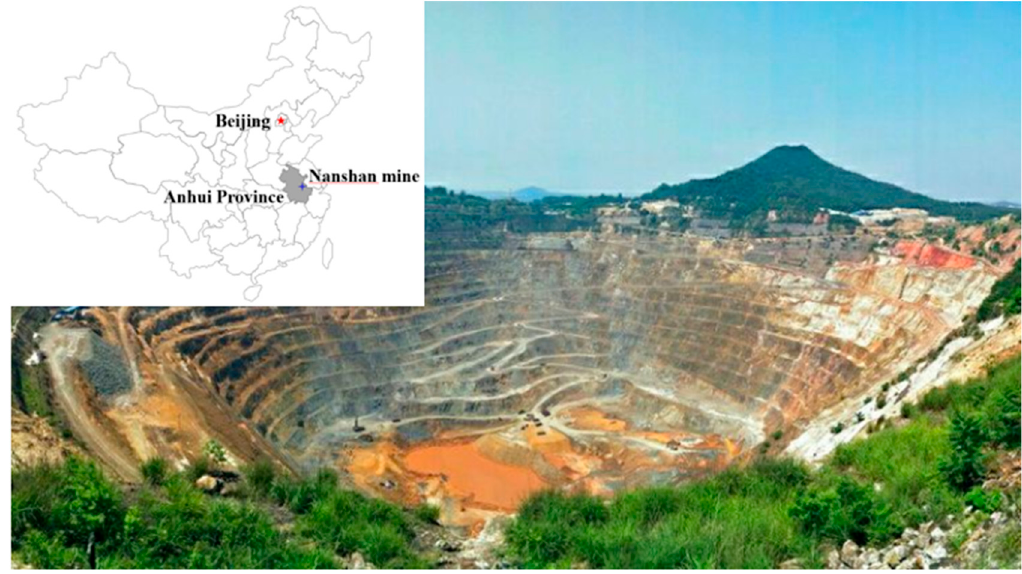
Figure 5. Washan pit of Nanshan mine.